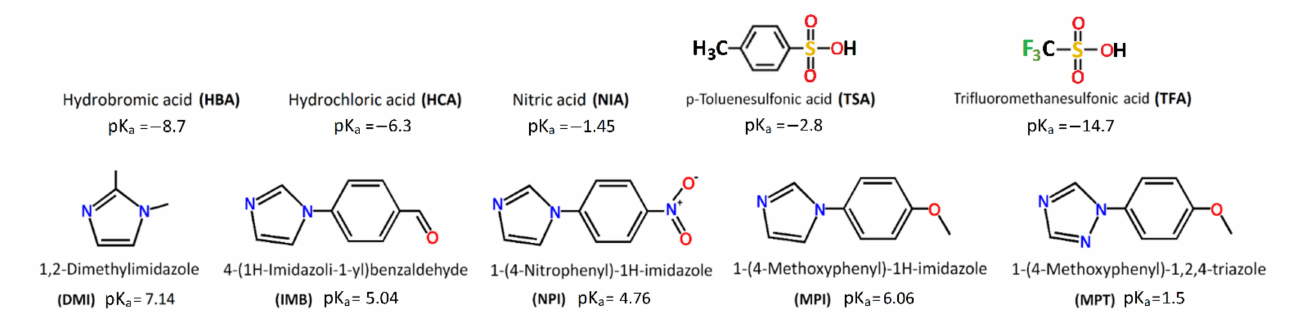
Scheme 1. Cocrystal formers studied herein and their corresponding abbreviations, along with the pK a